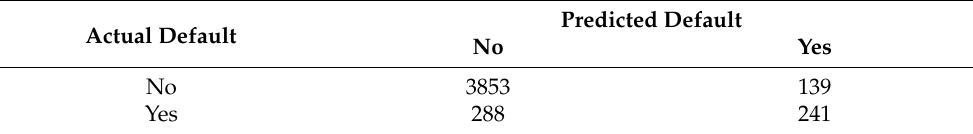
Table 6. Confusion matrix with C5.0 model.